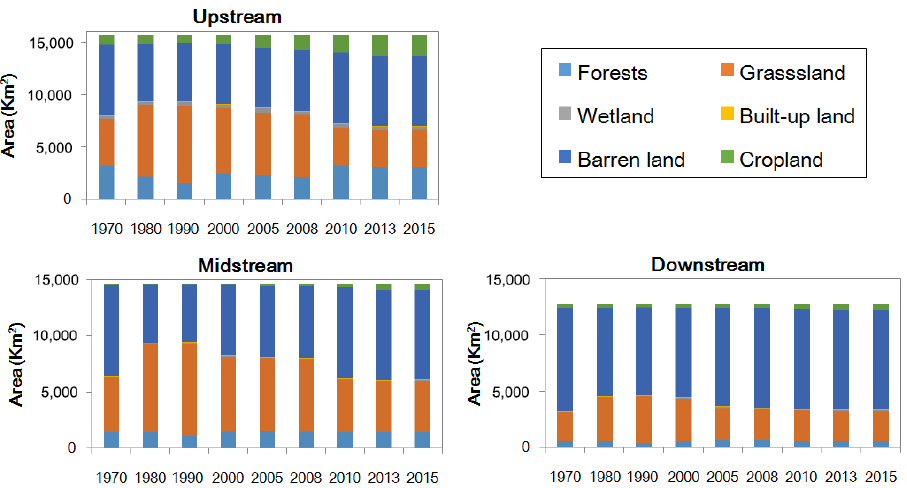
Figure 4. Land-use change in the mid-downstream Tarim River basin from 1970 to 2015.